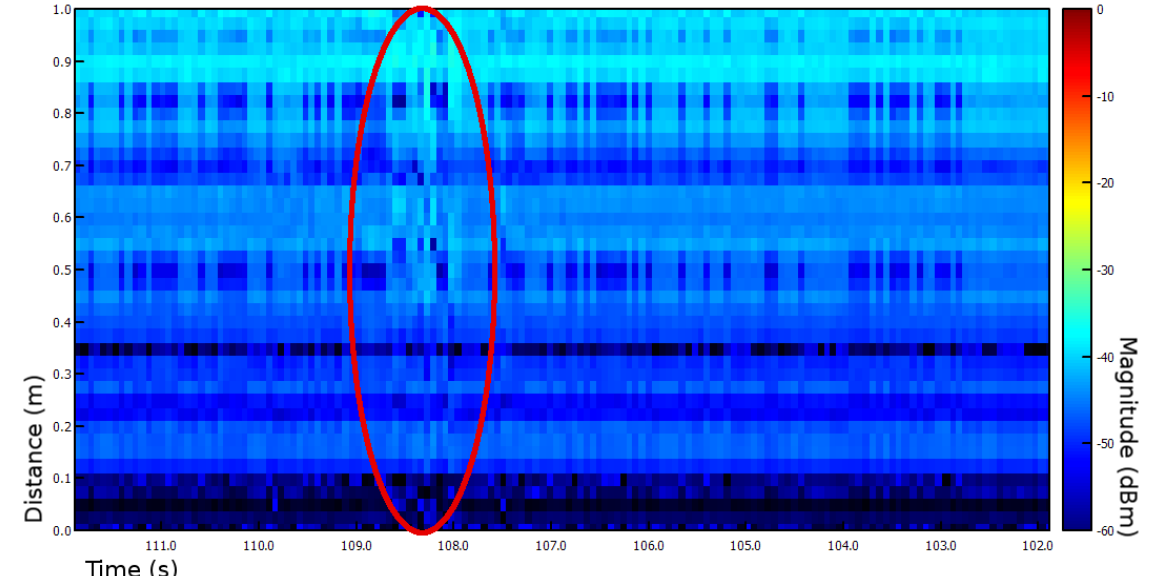
Figure 6. History plot showing an insect (108–109